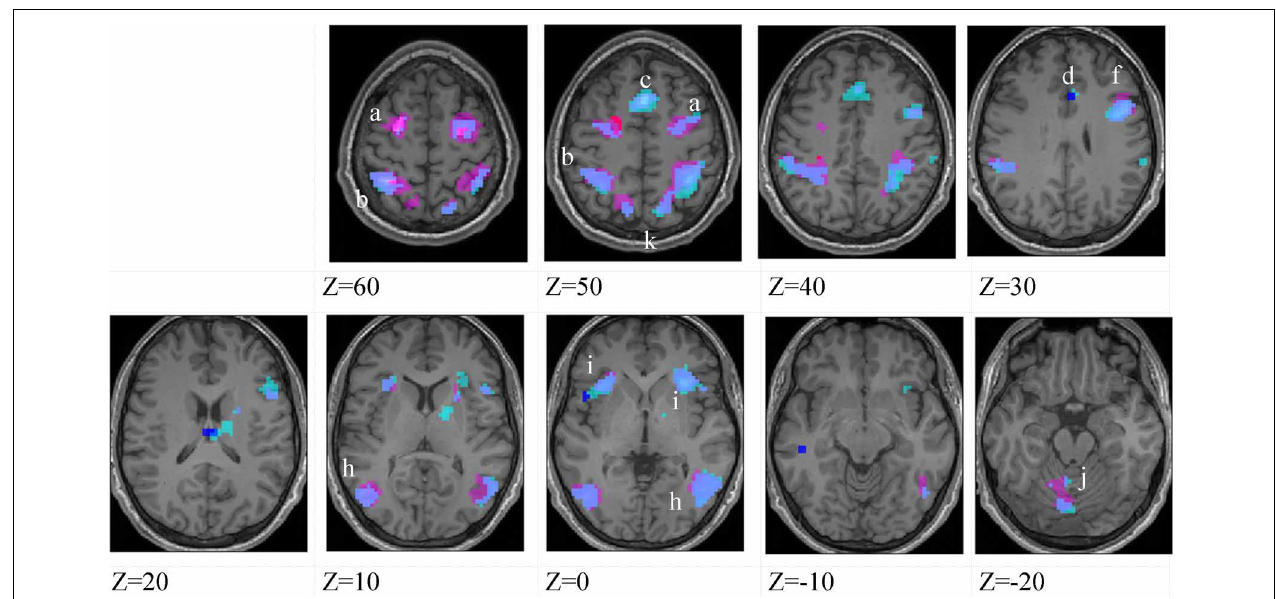
FIGURE 4 | Lower-skilled males. Second-level fMRI activations ( p < 0 . 005, FWE corrected, 25 voxels minimum cluster size) to deception identification (cyan) and direction identification (magenta) in point-light soccer video clips, relative to stimulus-matched non-biological motion (NBM) controls. Overlapping areas responding to both identification tasks appear purple. Activations above threshold (blobs) are displayed in co-registration with an individual normalized structural brain image and sampled in horizontal sections 10mm apart from z = 60 to z = − 20. In